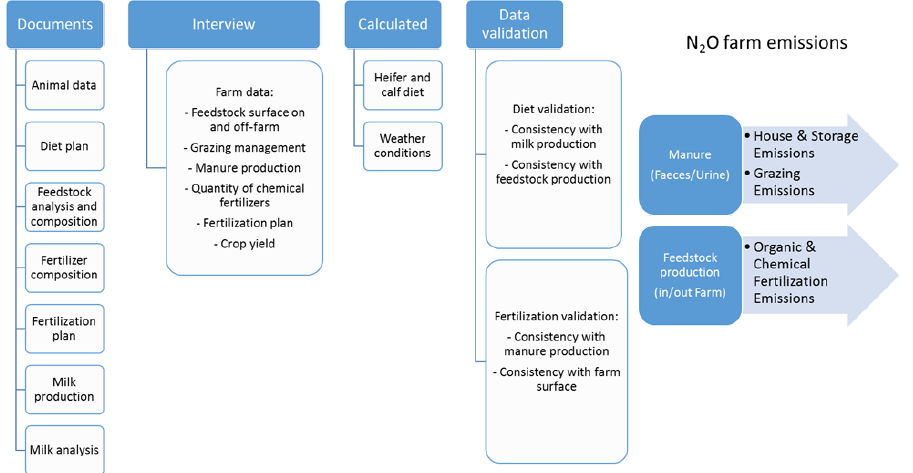
Figure 2. Scheme of the collection, calculation and control of the data from the 21 selected dairy farms analysed in the present study.